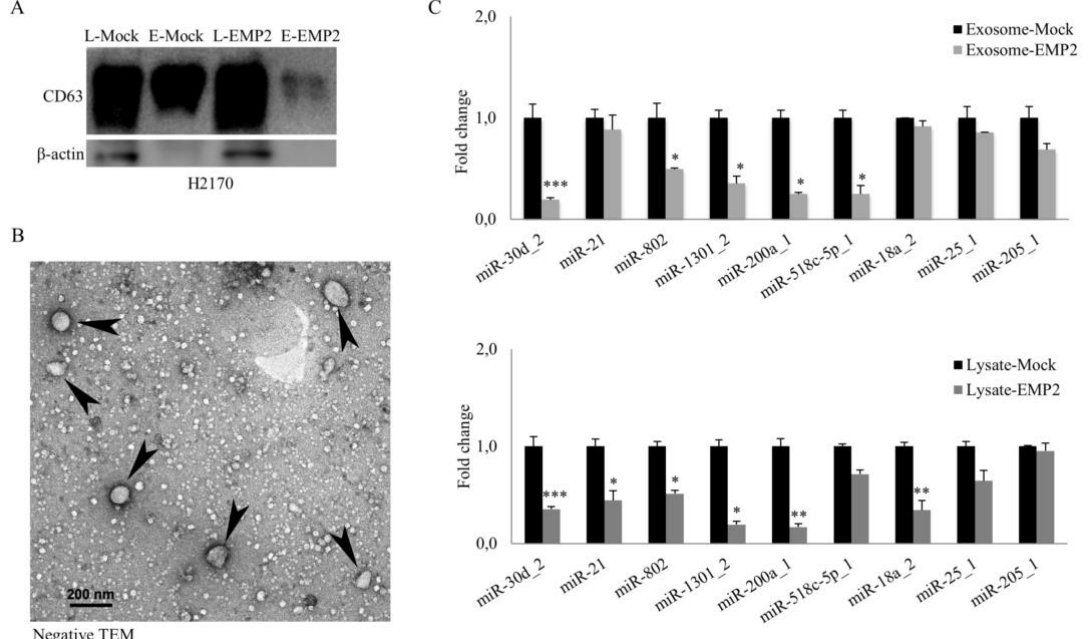
Figure 7. Characterization of exosomes secreted by H2170-transfected cells and altered miRNA expression in EMP2 overexpression. ( A ) Western blot analysis of the exosome marker CD63 from both cell lysates and exosomes. ( B ) The presence of membranous vesicles in the diameter range of 40–100 nm (arrowheads), as confirmed by transmission electron microscopy (TEM) analysis. ( C ) Overexpression of EMP2 significantly altered the expression of miRNAs related to regulation of the tumor microenvironment. * p < 0.05, ** p < 0.01, *** p < 0.001 when analyzed using Student’s t -test.